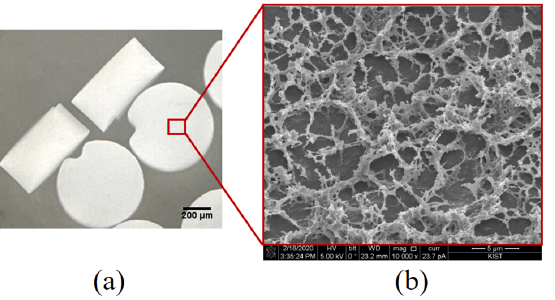
Figure 2. Structural characteristics of PIN; ( a ) A pictogram of a swollen disk-shaped PIN particle suspended in PBST buffer captured using an inverted microscope, 20× magnification; ( b ) Cryo-SEM (10,000×) showing the internal structure of the PIN particle.